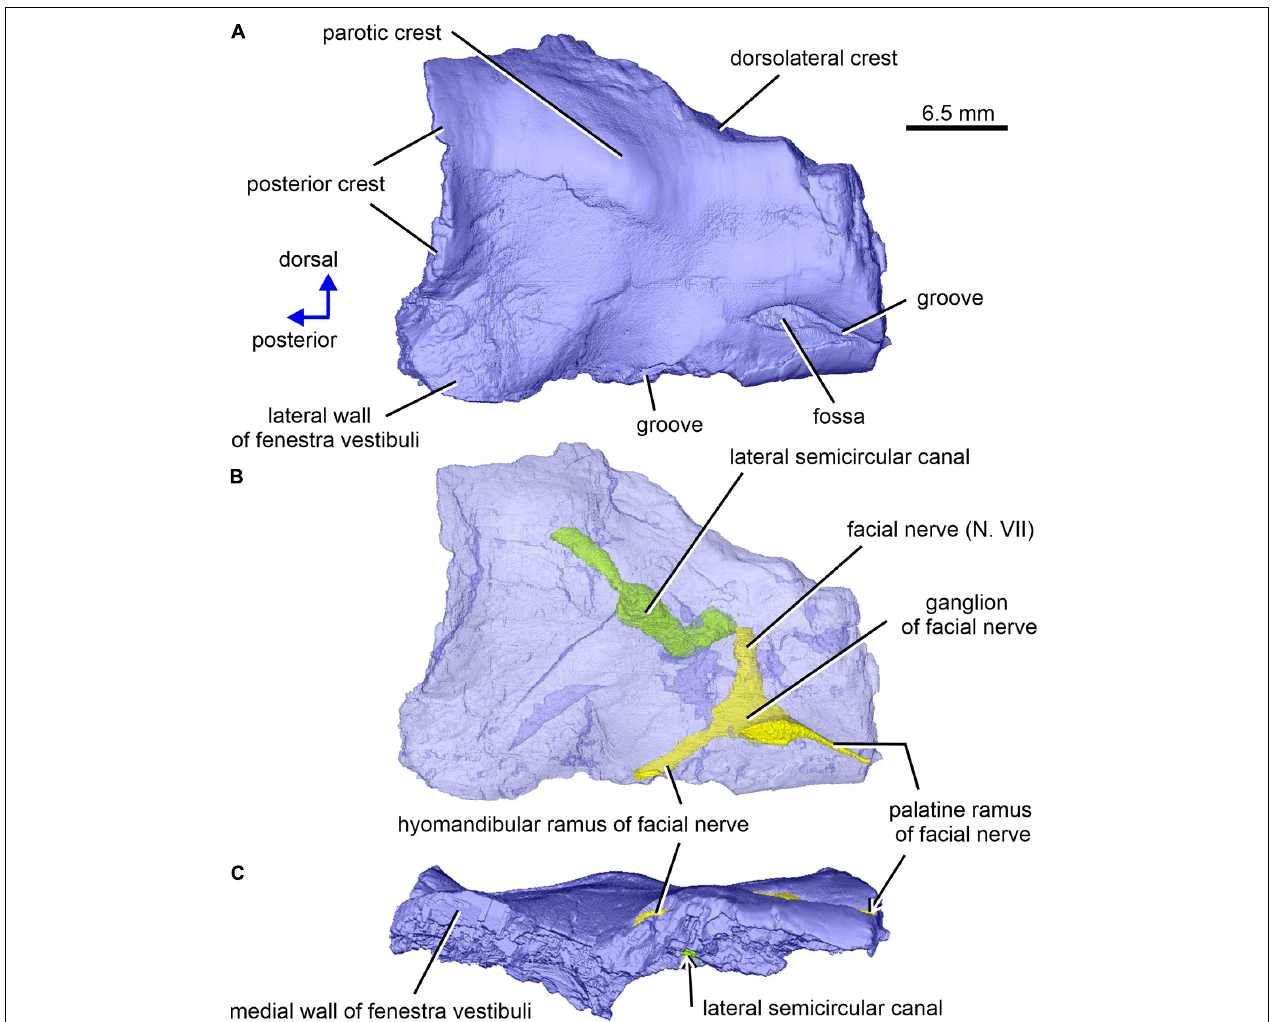
FIGURE 9 | Limnoscelis dynatis , CM 47653. Right prootic in lateral and slight posterior (A,B) and ventral (C) views. (B) Semitransparent prootic showing the course of nerves and lateral semicircular